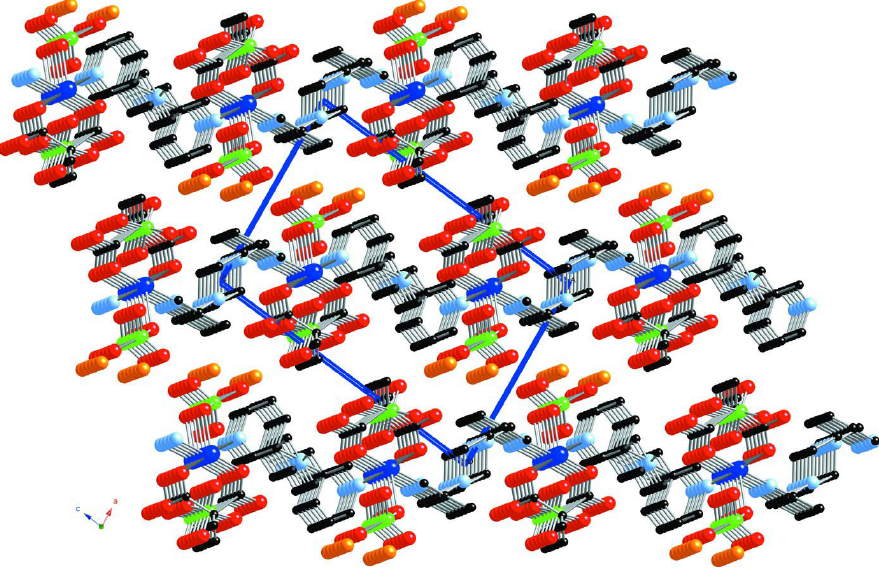
Packing diagram illustrating the interaction of pseudolayers via hydrogen bonding involving the dimethylmalonate carboxylate O atoms, co-crystallized water molecules, and unligated perchlorate